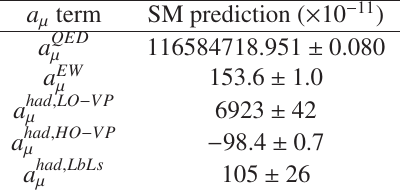
Figure 1. (left) Tree-level vertex diagram for a muon coupling to a photon and (left-center) the diagram cor- responding to the leading-order hadronic correction. Examples of diagrams for the higher-order hadronic cor- rections and for light-by-light scattering are shown in the right-center and right plots, respectively. The three leftmost plots are taken from Ref. [1]. Table 1. SM results for the di ff erent contributions to the muon anomaly a μ , taken from Ref.